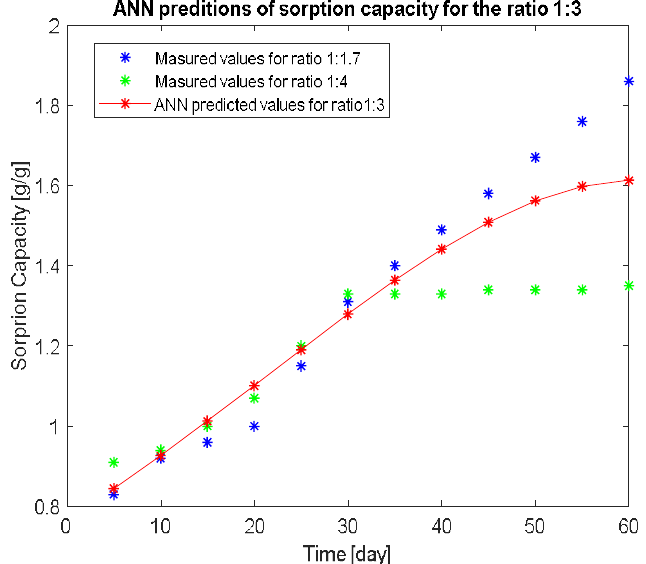
Figure 7. ANN predictions of the sorption capacity for the shungite and rice husk new ratio of 1:3, case of the 10% oil-contaminated soil.